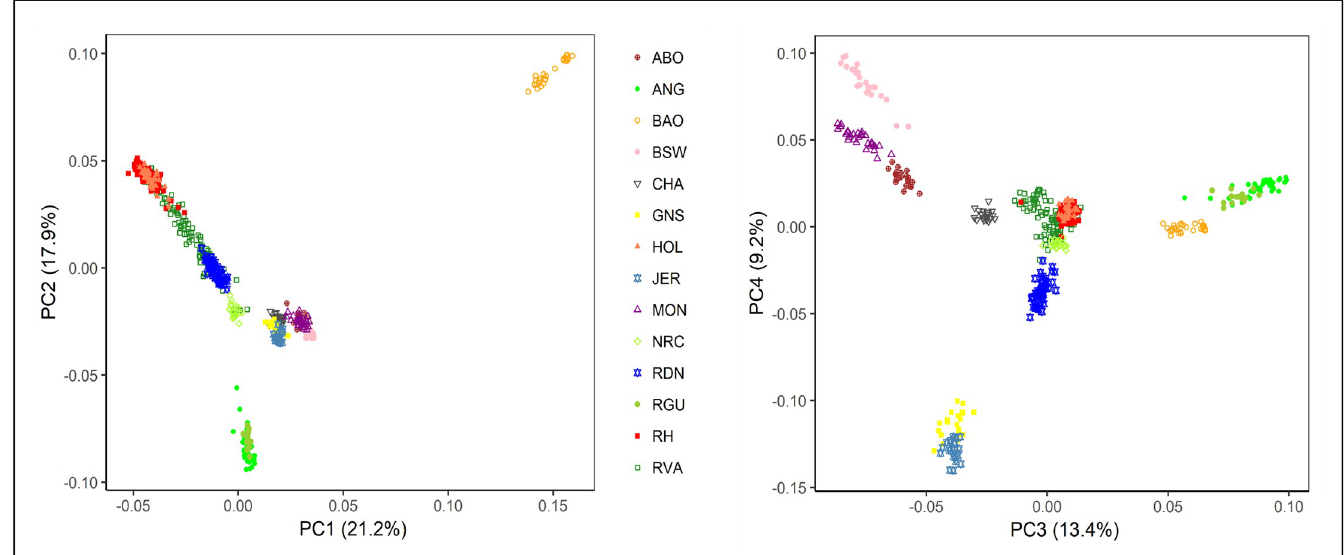
Fig 5. Principal component analysis of 14 cattle breeds distinguished by shape and colour. Based on 19,971 SNPs, the first four components together accounted for 61.7% of variation in the data.